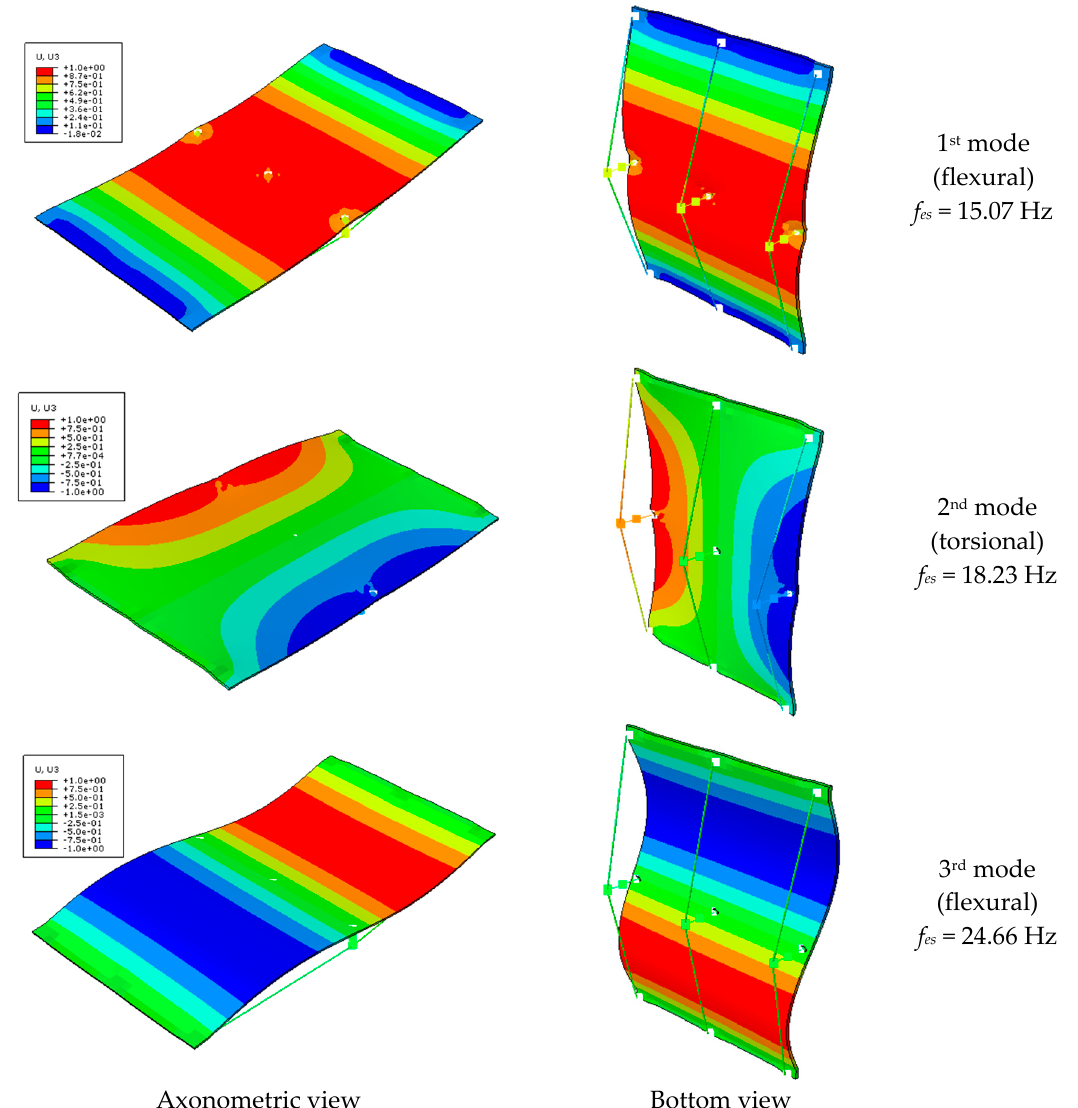
Figure 7. First vibration modes and frequencies of the empty structure (ABAQUS, axonometric and